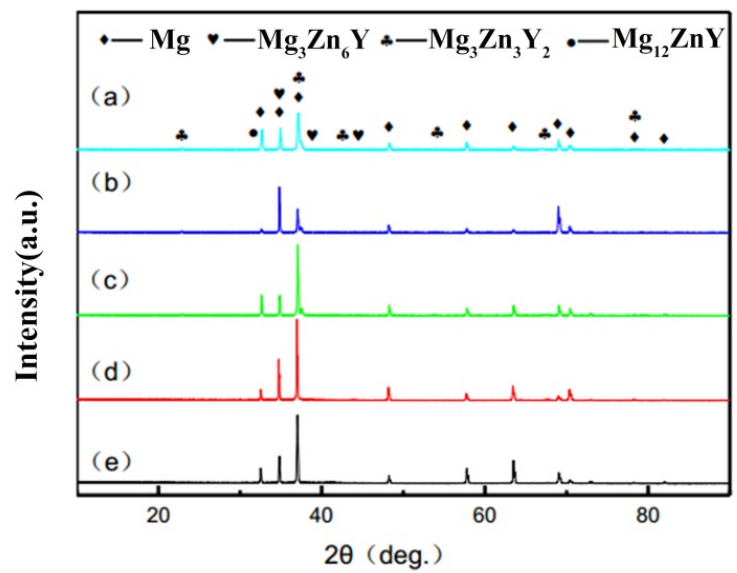
Figure 6. XRD patterns of the liquid forging parts with different Y-element contents: ( a ) Mg-0YL, ( b )